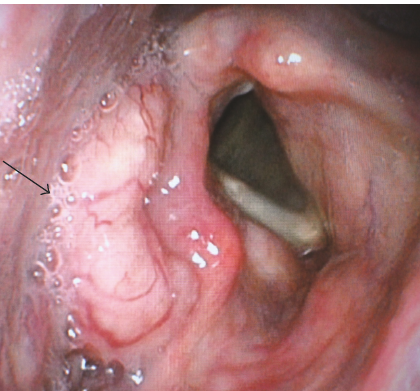
Figure 1: Fiberscopic view of the hypopharynx filled with a large soft tissue mass in the right pyriform sinus